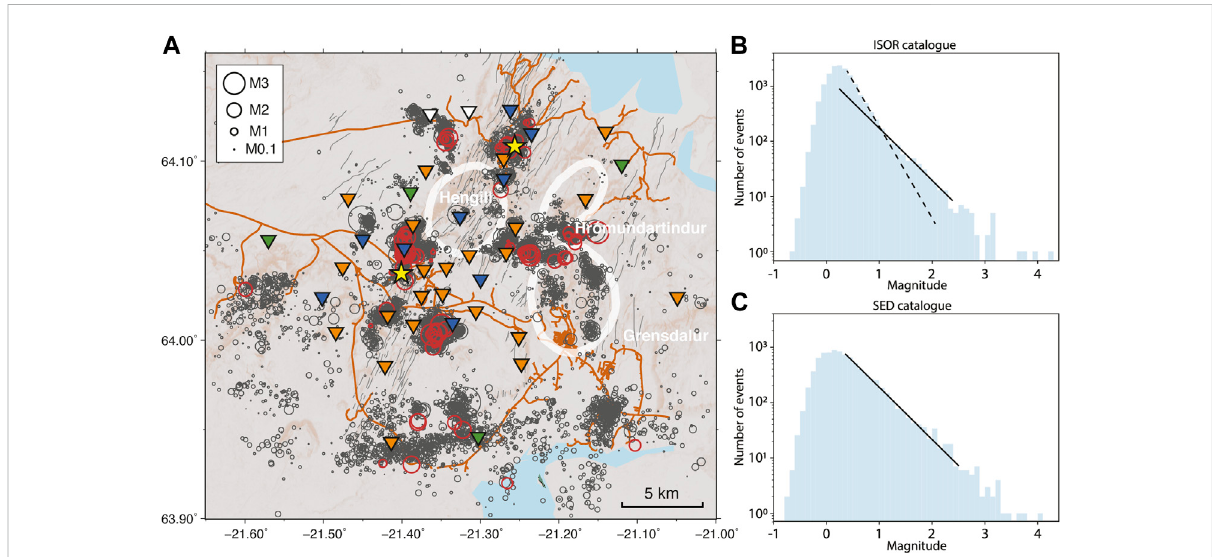
FIGURE 2 (A) Seismic network and seismicity across the Hengill high-temperature geothermal area. From December 2018 to January 2021, about 15,640 earthquakes were reported by ÍSOR (gray circles), forming several clusters. The thin gray lines in the SW-NE direction represent fi ssures (Sæmundssonetal.,2016)andtheorangelinesdelineatethemainroads.Theredeventsareusedtocomputethetravel-timetomography.Thewhite lines mark the three major volcanic centers. Richter local magnitude (M L ) distribution of the ÍSOR (B) and SED-HQ (C) catalogs. The lines indicate the b-value(s) that result from the distribution. The ÍSOR catalog shows a bias of M L for events < 1.0 introduced by the strong microseisms that can be mitigated with an additional band-pass fi lter (C)